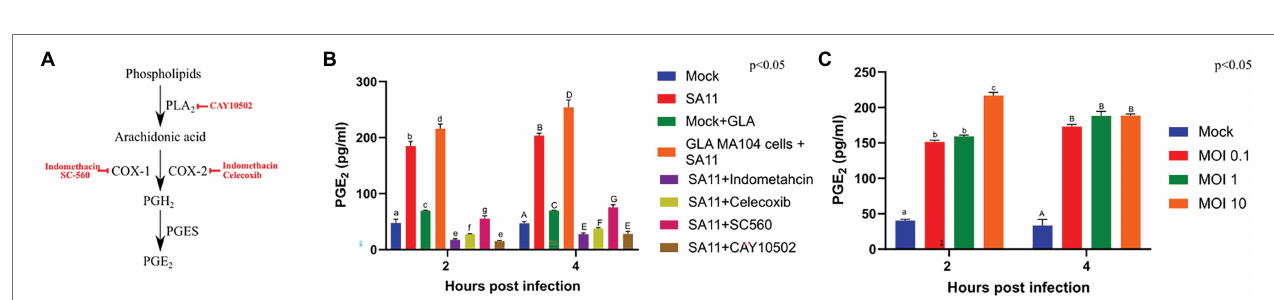
FIGURE 1 | Conversion of GLA to AA at 16 h post-infection. (A) γ -Linolenic acid (GLA) is converted to dihomo- γ -linolenic acid by elongases which is subsequently converted to arachidonic acid (AA) via Δ 5 -desaturase. Finally, AA is converted to PGE 2 by either COX-1/2 and PGES (Funk, 2001). (B) The effect of rotavirus on the relative percentage of GLA (blue) and AA (red) in the neutral lipid fraction (B) and phospholipid fraction (C) was evaluated in unsupplemented (mock; SA11) and supplemented (mock + GLA; SA11 + GLA) MA104 cells. Error bars indicate the standard error of the mean ( n = 3). Lowercase and uppercase letters indicate a significant difference ( p < 0.05) compared to the control. Cyclooxygenases (COX1/2), prostaglandin E 2 synthase (PGES); and prostaglandin E 2 (PGE 2 ).